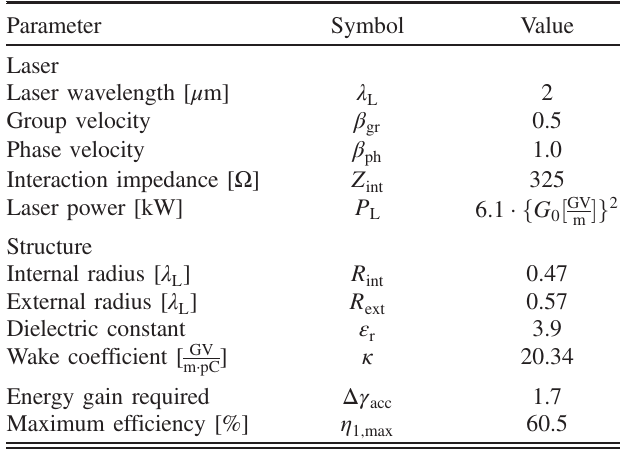
TABLE I. Parameters of the laser and the envisaged structure shown in Fig.